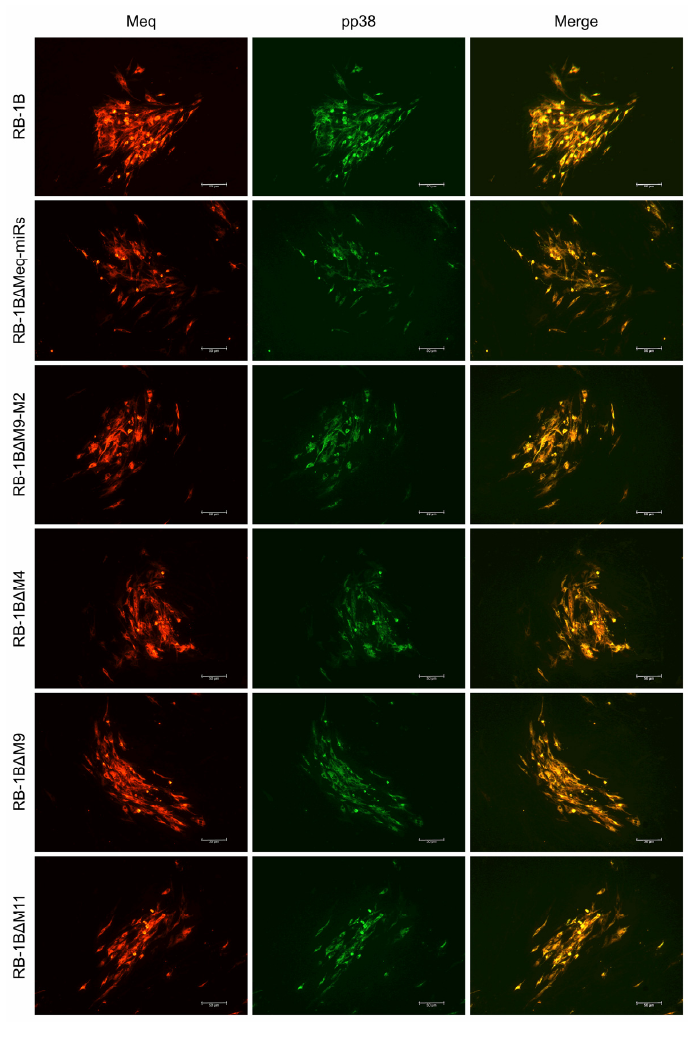
Figure 4. Immunofluorescence assays for detection of viral protein expressions in chicken embryo fibroblast (CEF) infected with RB-1B mutant viruses. Meq, Marek’s EcoQ-encoded protein; pp38, phosphoprotein 38. Scale bar = 50 μ m.